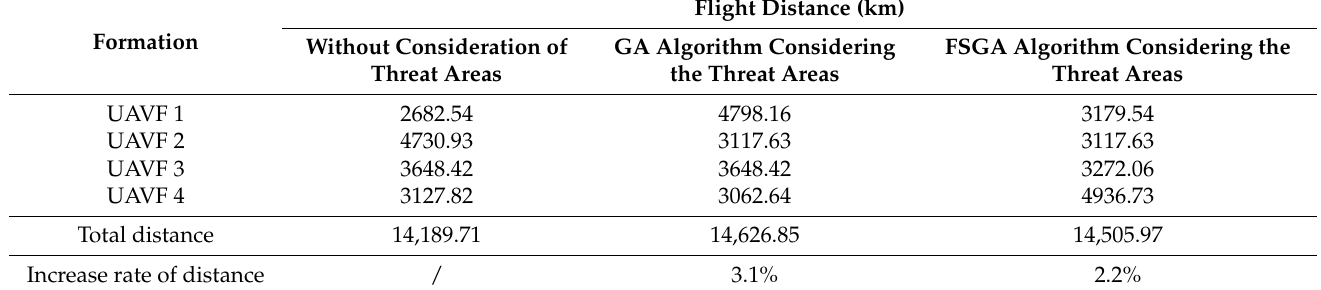
Figure 11. Results of the path planning for the UAVFs obtained using different methods. ( a ) Optimal route without threat areas; ( b ) Optimal route planning calculated by the GA algorithm; ( c ) Optimal route planning calculated by the FSGA algorithm; ( d ) Optimal solution history of the two algorithms. Table 4. Detailed information about the flight distances of the UAVFs for the three situations.